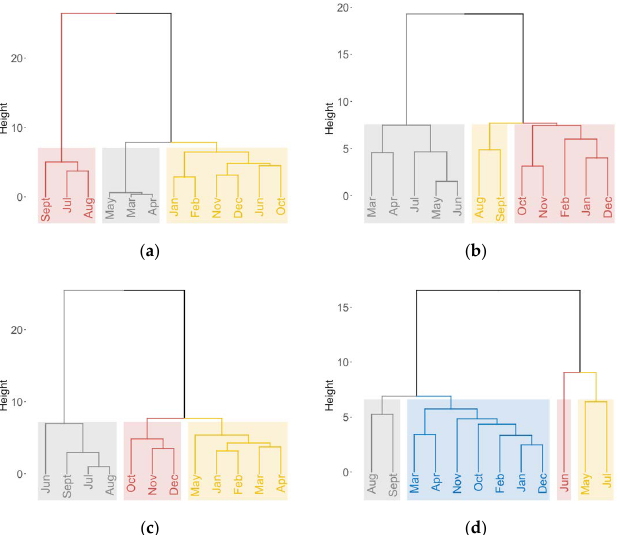
Figure 3. Cluster analysis of months with similar frequency of ( a ) cyclonic eddies; ( b ) anticyclonic eddies; ( c ) coastal upwelling; ( d ) filaments, in the Northern Gulf of California. Colors of clusters represent highest to lowest frequency of events in the following order: red, yellow, grey, blue.